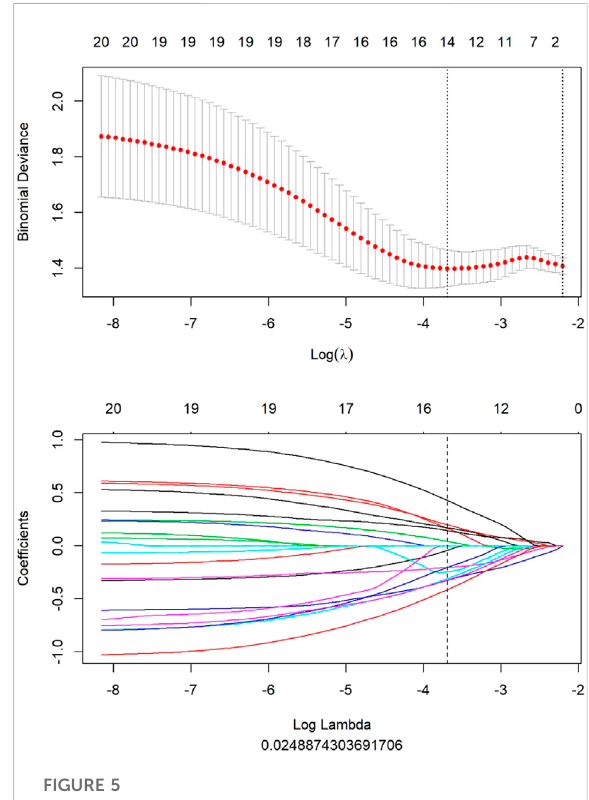
FIGURE 5 AllfeaturesofPETimageselectedtopredictCOX-2byLASSO algorithm. When lambda was 0.025 in predicting PLNM with the LASSO algorithm, 14 most informative features were reserved to predict PLNM in the training dataset.